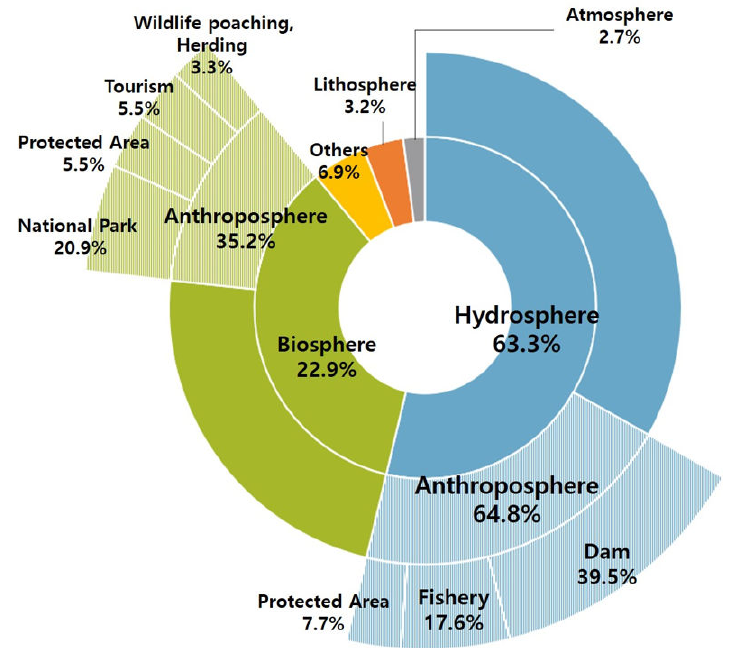
Figure 4. Ratio of the articles related to the Earth four spheres and anthroposphere.